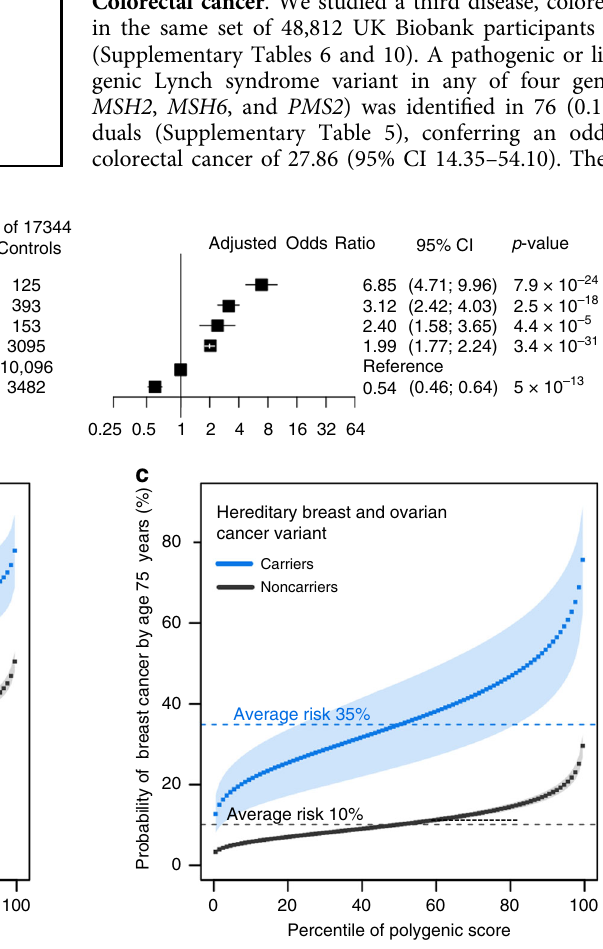
Fig. 2 Interplay of monogenic and polygenic risk for breast cancer. a Risk of breast cancer by monogenic and polygenic strata (case-control study; n = 19,264). Carriers and noncarriers were strati fi ed into three groups according to their polygenic score — low, intermediate, or high de fi ned as the lowest quintile, the middle three quintiles, and the highest quintile of the polygenic score distribution, respectively. The odds ratio was assessed in a logistic regression model with age and the fi rst four principal components of ancestry as covariates. Noncarriers with intermediate polygenic score served as the reference group. The black boxes indicate the adjusted odds ratio. The horizontal lines around the black boxes indicate the 95% con fi dence intervals. b Predicted odds ratio for breast cancer in each percentile (dots) of the polygenic score distribution for carriers (blue) and noncarriers (black) of hereditary breast and ovarian cancer variants in the cohort study derived from the UK Biobank ( n = 26,597). Noncarriers with median polygenic score served as the reference group. c Predicted probability of coronary artery disease by age 75 years in each percentile (dots) of the polygenic score distribution for carriers (blue) and noncarriers (black) of hereditary breast and ovarian cancer variants in the cohort study derived from the UK Biobank ( n = 26,597). The shaded area around the dots represents the 95% con fi dence interval. The horizontal dashed lines show the probability of disease for people with average polygenic risk score. HBOC hereditary breast and ovarian cancer. p -values in the fi gure were estimated by the Wald Test. Statistical signi fi cance was set at p < .05, and two-sided p values were used.